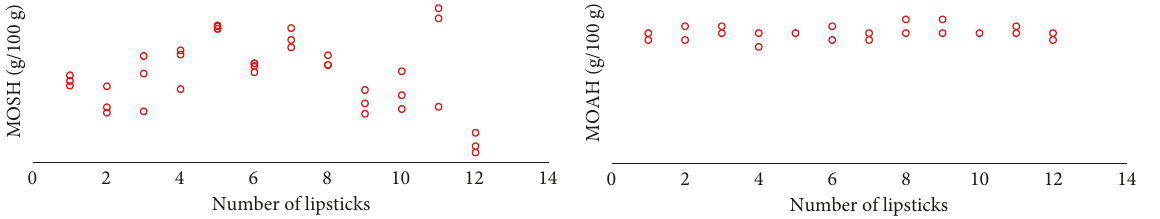
7.27, f(0.95) 2.22, and the result is highly (cid:31) (cid:31) 1.09, f(0.95) 2.22, and the result is homogenous. (cid:31) (cid:31)